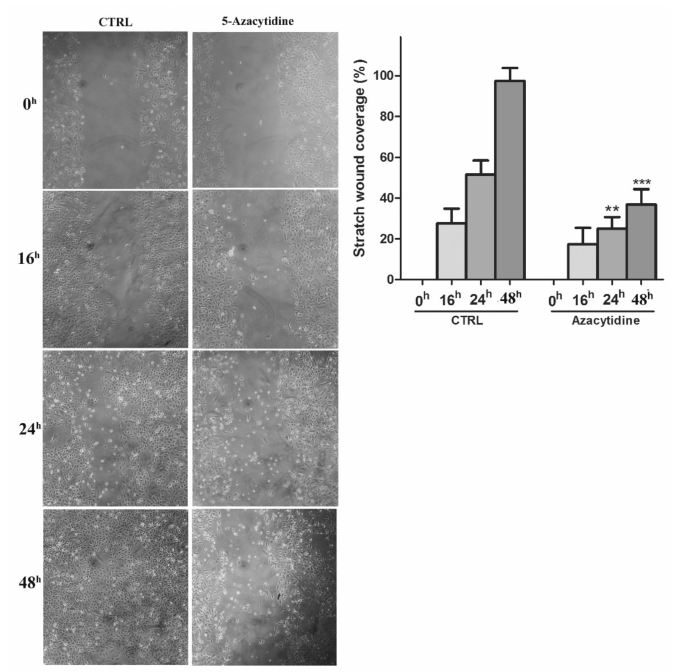
Figure 5. Cell migration (scratch wound healing assay). Representative images are shown from four independent experiments. Histograms show coverage percentage after 5-Aza-Cdr treatment for both control and treated samples. Values of percentage wound coverage ± SEM ( n = 4). ** p < 0.01; *** p < 0.001 ( t -test).